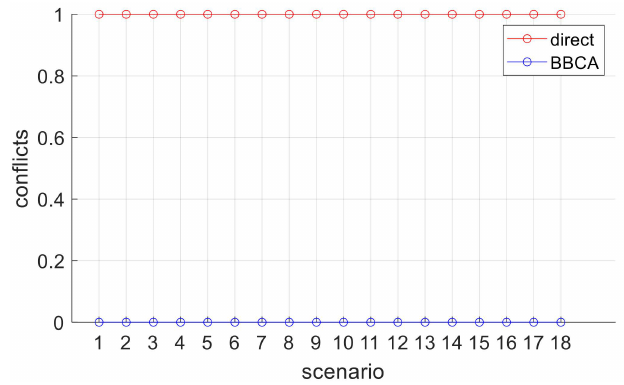
Figure 11. Two-UAV study: conflicts produced.